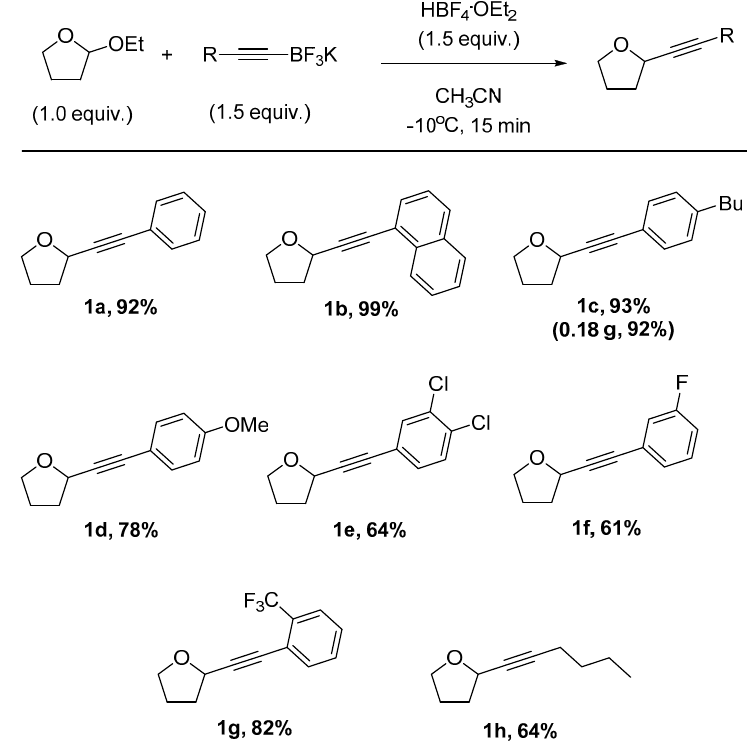
Figure 1. Reactions of potassium alkynyltrifluoroborate salts with 2 ‐ ethoxytetrahydrofuran.